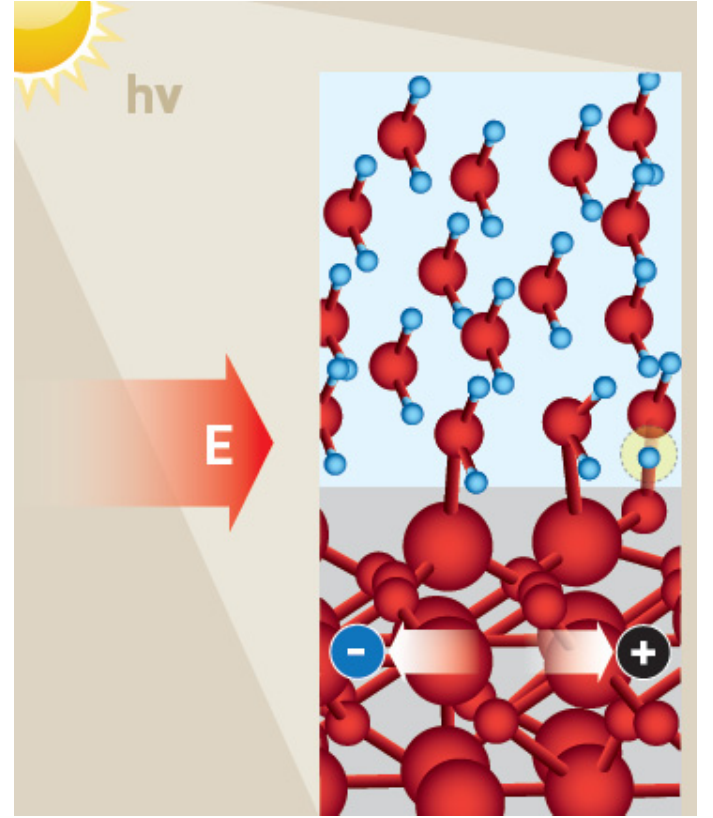
Figure 3. Schematic of an external field promoting the separation of an electron and hole in a semiconductor (001-hematite iron oxide, in this case) due to the opposite charges thereon, along with dipolar alignment of water molecules. There is enhanced diffusion of holes to the surface to facilitate water splitting, whilst the intramolecular strain of water dipole alignment also enhances break-up. Also depicted is a proton becoming hydroxylated to a bridging oxygen atom; strain from dipolar alignment also facilitates this. The symmetric aligning of these dipoles arises due to field imposition. Without it, dipoles would not be aligned. Figure 5 denotes data for “trans-face” field exposure in the case of the unit cm 2